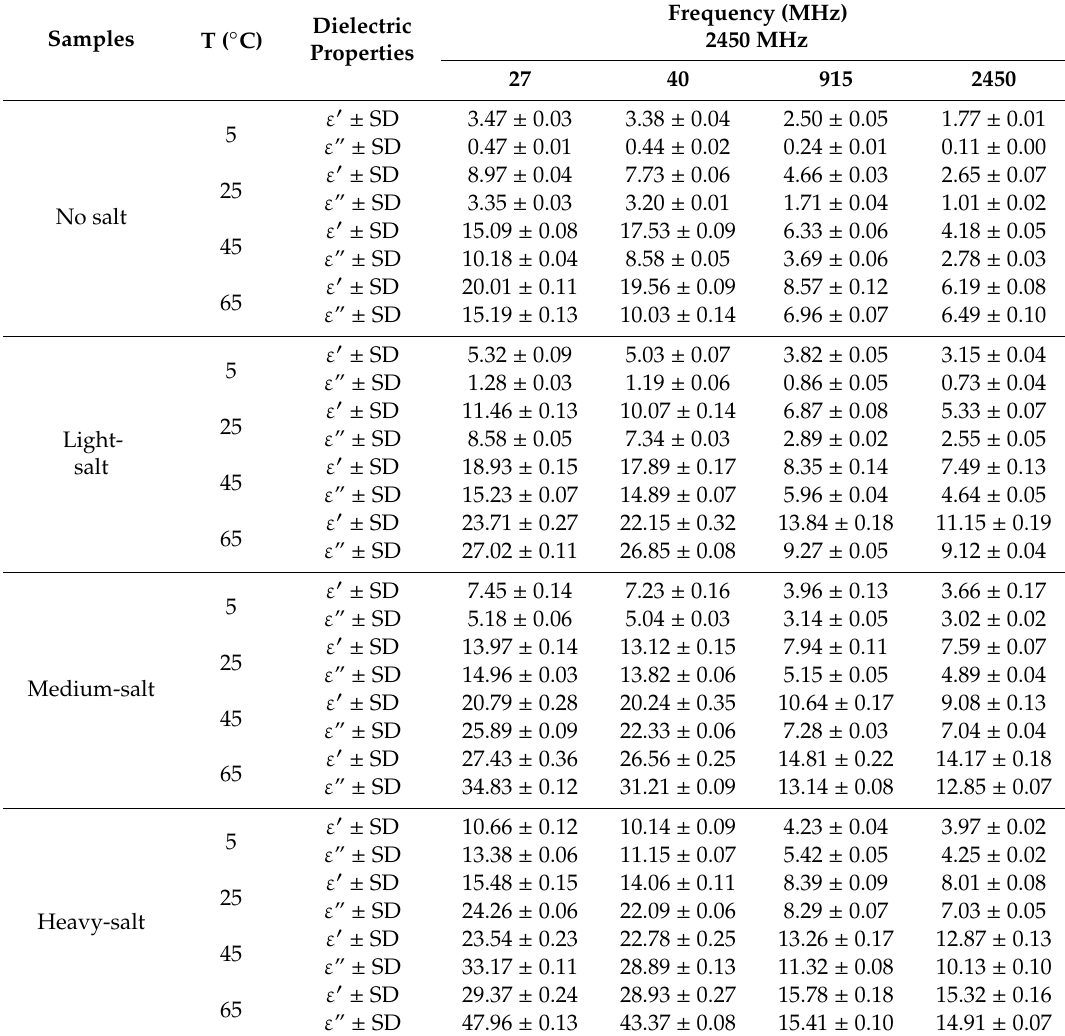
Table 7. Dielectric properties of pecan nuts with di ff erent salt contents (moisture content: 15%).